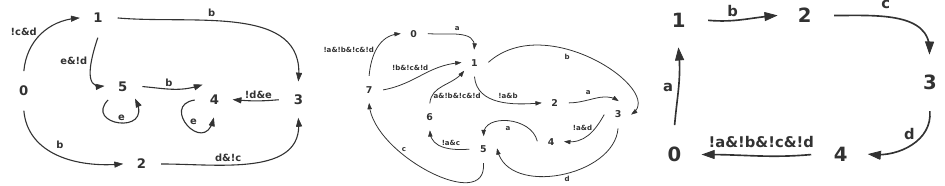
Figure 4. The synthesized strategies used in the